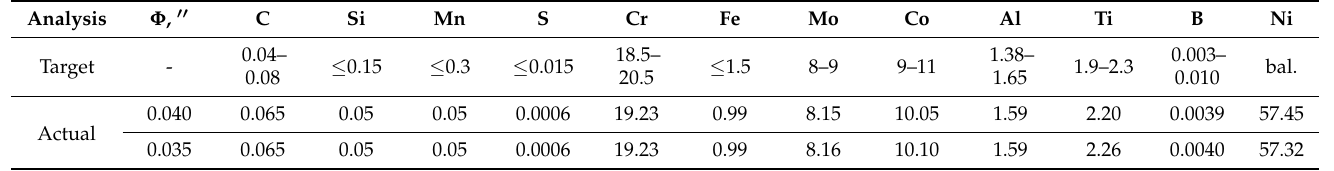
Table 1. Chemical composition of solid wire electrodes HY282 (wt%).